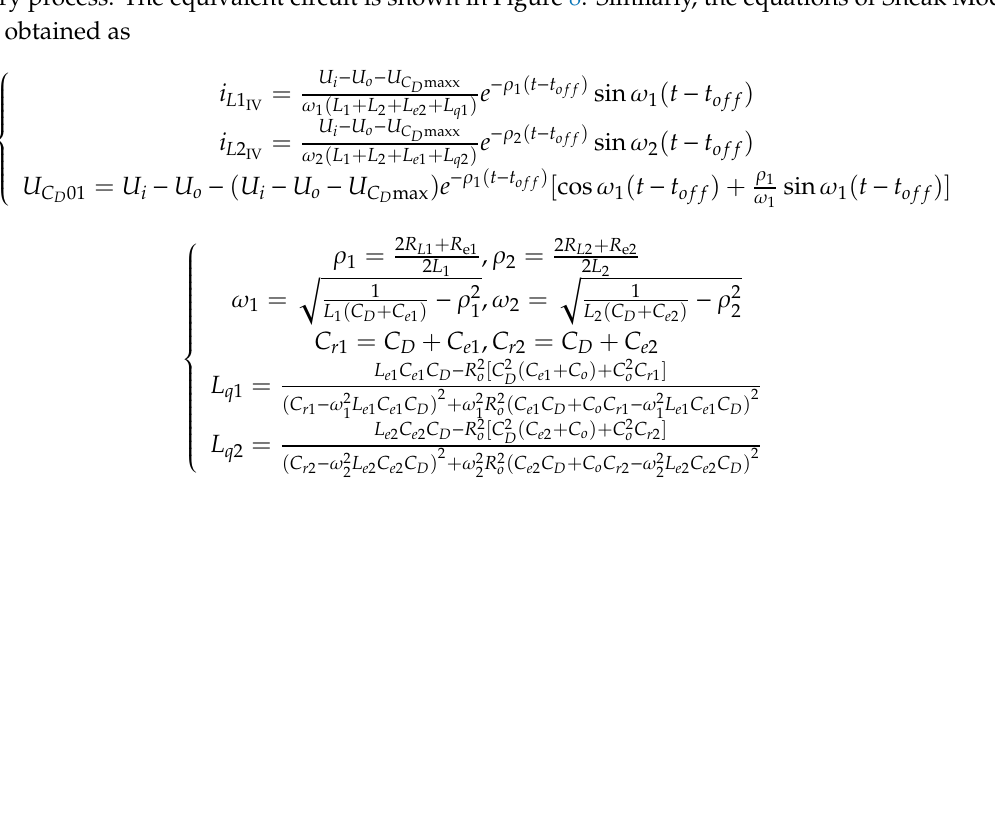
C Do 2 C Do 1 Figure 5. Equivalent circuit of Mode 2. Mode 3, t